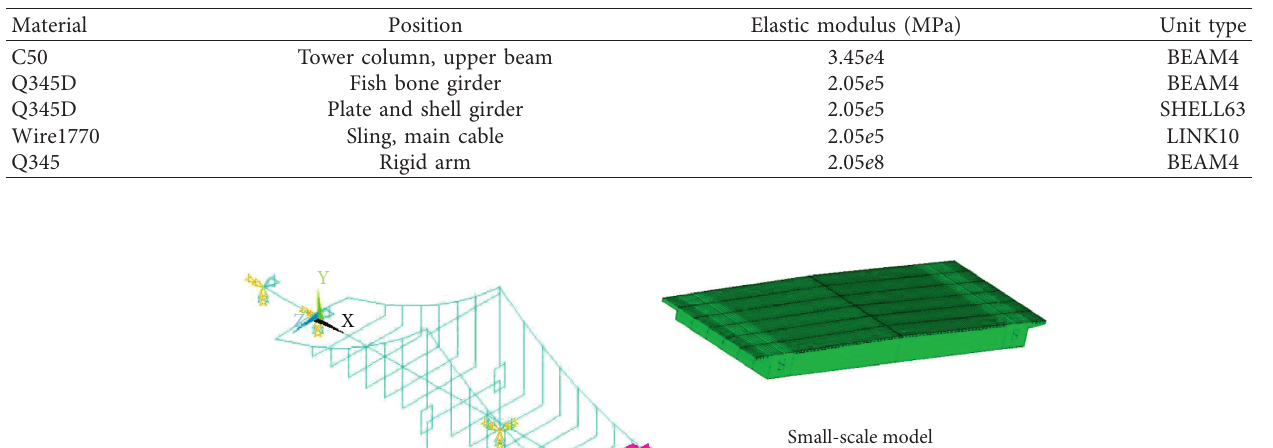
Table 3: Specific information of the finite element model.